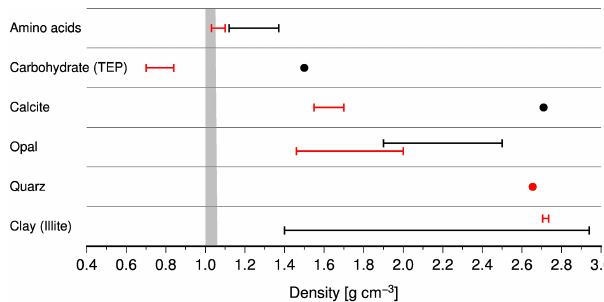
Figure 4. Densities of bulk components including quartz and illite as representatives of lithogenic matter (red lines and circle). Black circles and lines indicate the densities of crystalline analogues and of cellulose as an example of a carbohydrate. The data were com- piled from the literature and the references are given in the text. The grey area shows the density range of